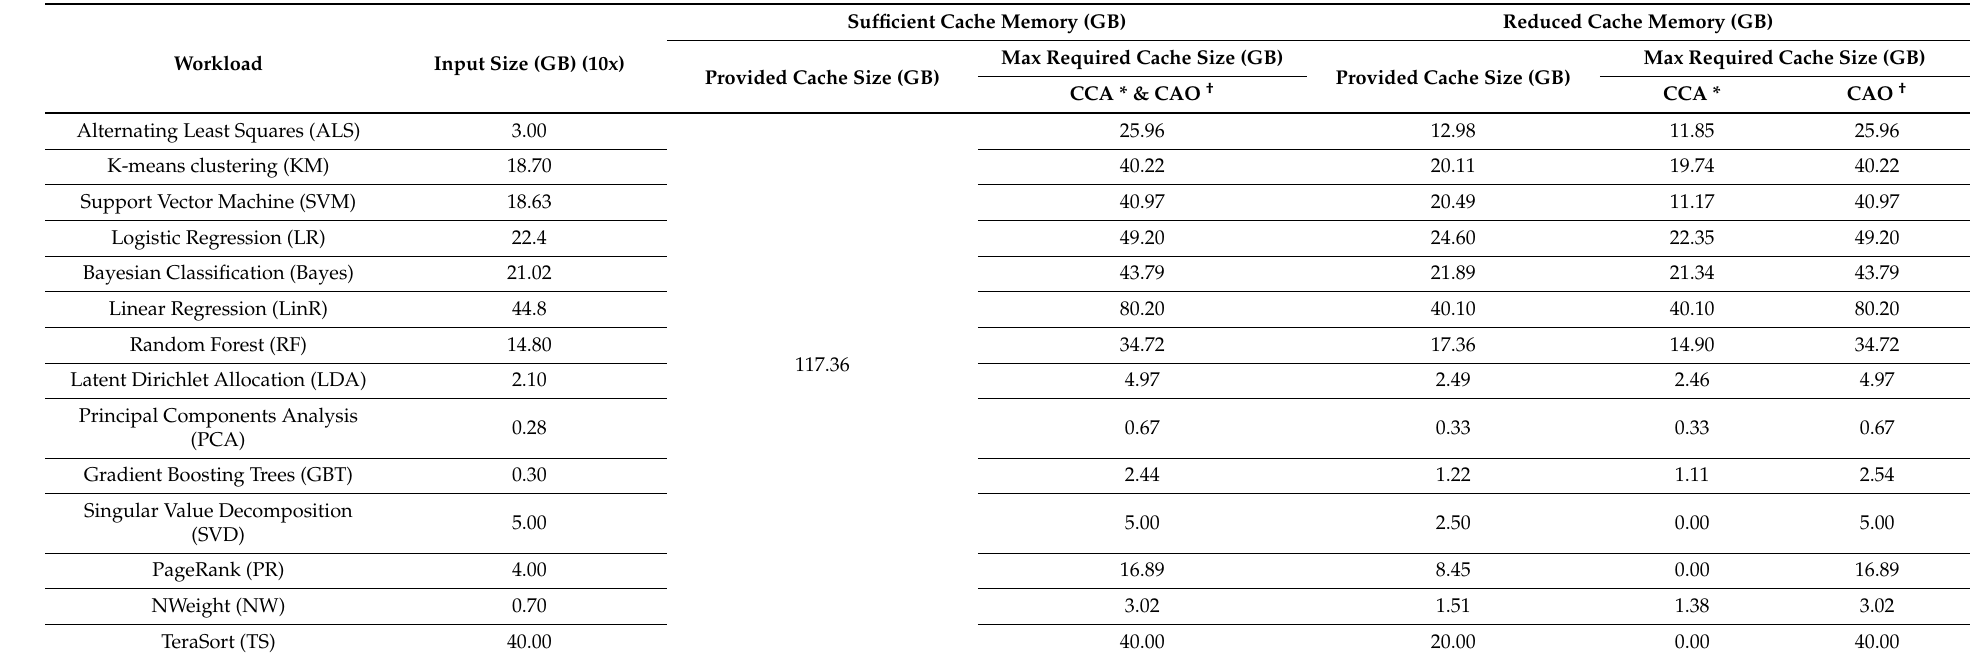
Table 3. Summary of caching on 14